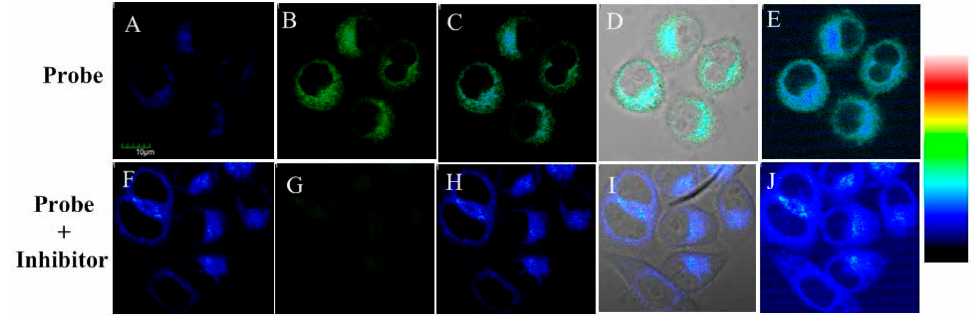
Figure 5. Fluorescence microscopy images for HeLa cells: ( A – E ) cells incubated with probe 1 for 30 min; and ( F – J ) cells incubated with inhibitor levamisole hydrochloride (5 mM) for 30 min and then with the probe 1 for another 30 min. ( A , F ) From blue channel; ( B , G ) from green channel; ( C , H ) overlay imaging of blue channel and green channel; ( D , I ) overlay imaging of blue channel, green channel and bright field; and ( E , J ) pseudo color imaging of blue channel and green channel. λ Ex = 405 nm. Blue channel λ Em : 410–460 nm and green channel λ Em : 470–530 nm. Scale bar: 10 μ m.